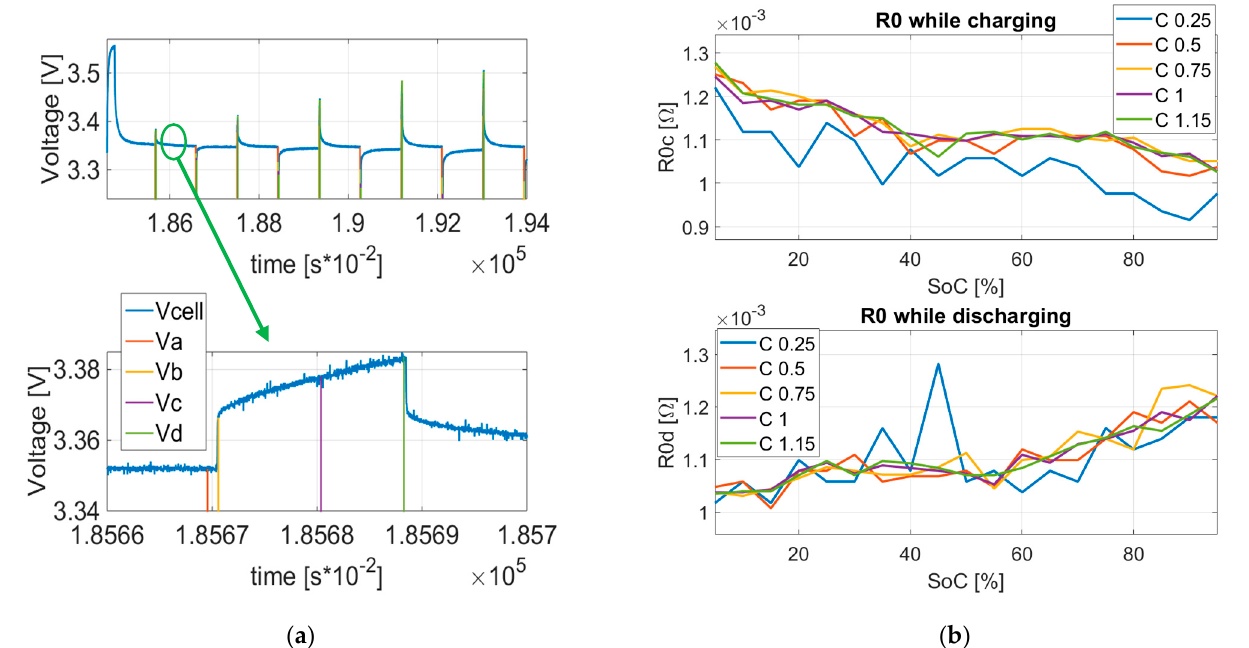
Figure 4. ( a ) The voltage response of the LFP cell during HPPC; ( b ) The ohmic resistance of the cell.